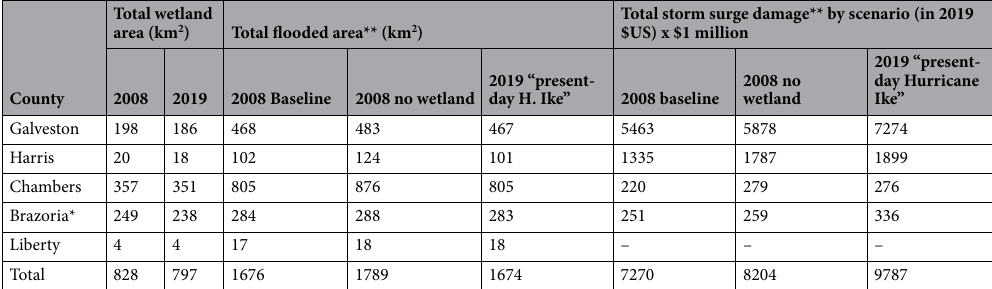
Table 1. Total wetland area, total flooded area and total storm surge damages from Hurricane Ike for each county in the study area for all three scenarios (2008 Baseline, 2008 No Wetland and 2019 “Present-day Hurricane Ike”). All dollar values rounded up to the nearest 1,000,000. *Only the part of the county flooded by Hurricane Ike is included in this analysis. **Only where flood height is above 0.1 m.